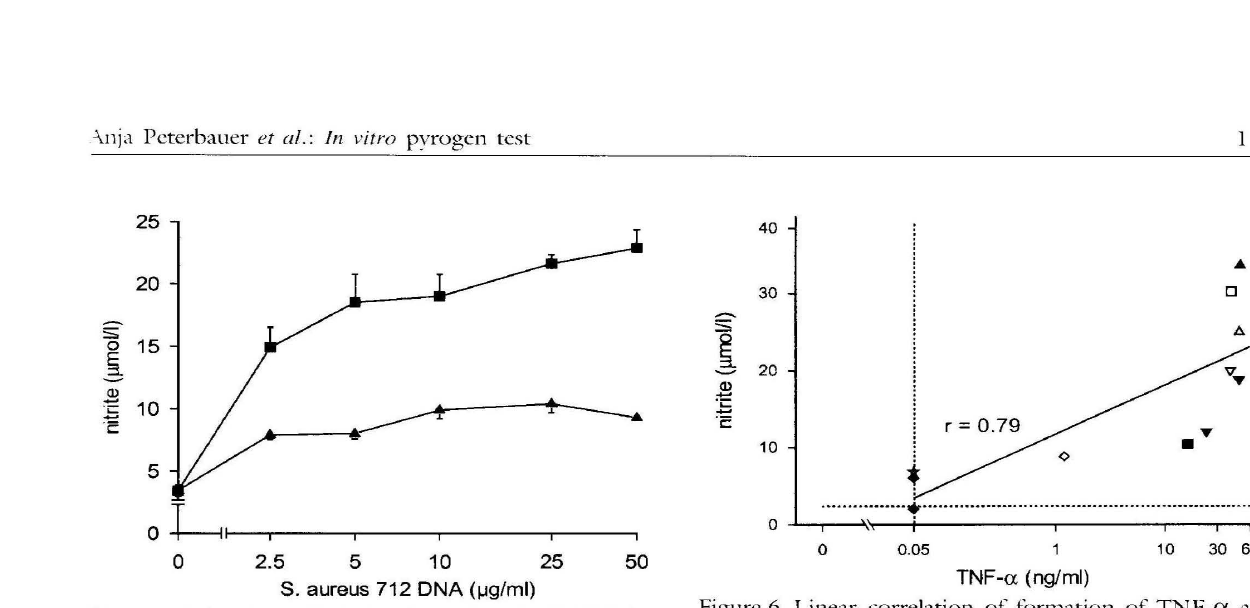
Figure 6. Linear correlation of formation of TNl-"-a and nitrite measured in supernatants of RAvV264.7 cells grown in DMEM/FCS and stimulated by 25 V /ml IFN y for 38 h.dFN-y, LPS E. coli 055:135, diphosphorvl lipid a E. coli F583, monophosphon'l lipid A E. coli F583, ' detoxified LPS from E. coli 055:135 .• supernatant fron1 P aemgil1o.1ll 11 :250 I .... supenurant tl'om S. UllJ"eus (1 :250 ), Tolig:onuclcutides ,oligonucleotide 1668, contain ing the ;:;'-Cp<"'~-3-'l11ot1f typically tClllnd in procan'otic D:-\ .,\, .1 recentk identified inducer of septic shock and